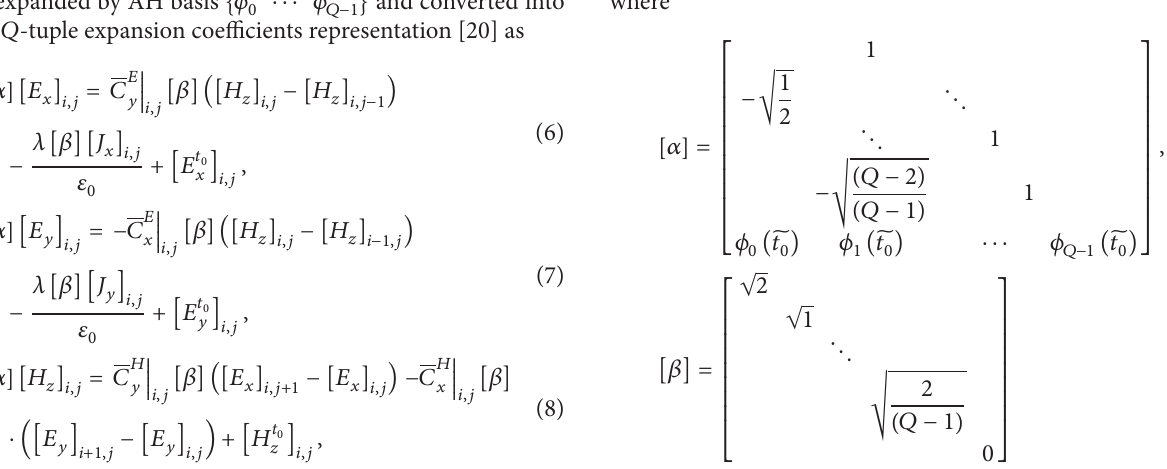
Figure 1: AH transformation for calculating an output signal from an input signal. (a) An input signal. (b) The AH basis with the parameters: = 0.5𝑡 𝜆 = 0.16 , 𝑄 = 60 , and 𝑡 𝑓 𝑄 . (c) The absolute value of the transformation matrix for reconstruction method and